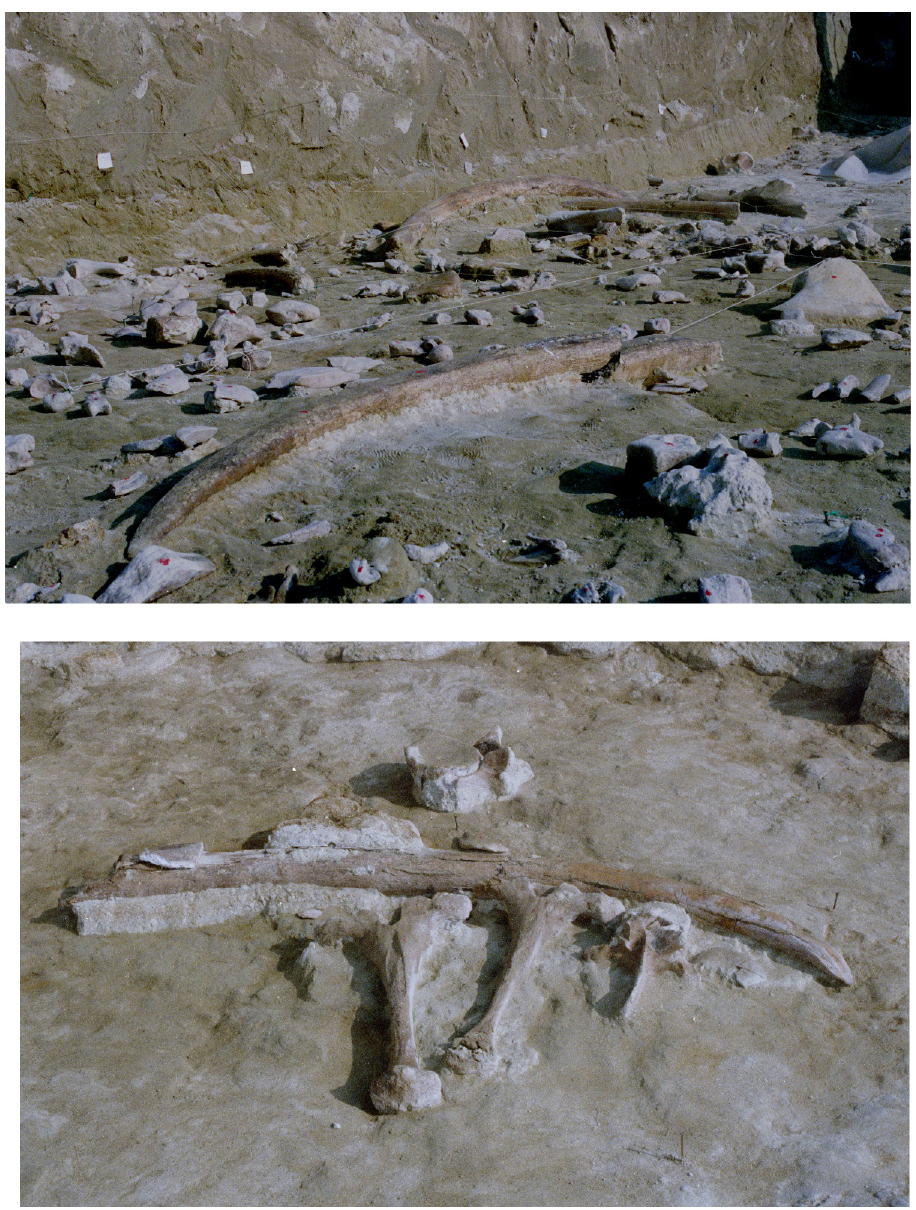
Fig 3. CdG excavation photo. Top: note the tusks and small objects at slightly different elevation. Bottom: two elephant neural spines and a vertebra of a smaller animal washed up against a